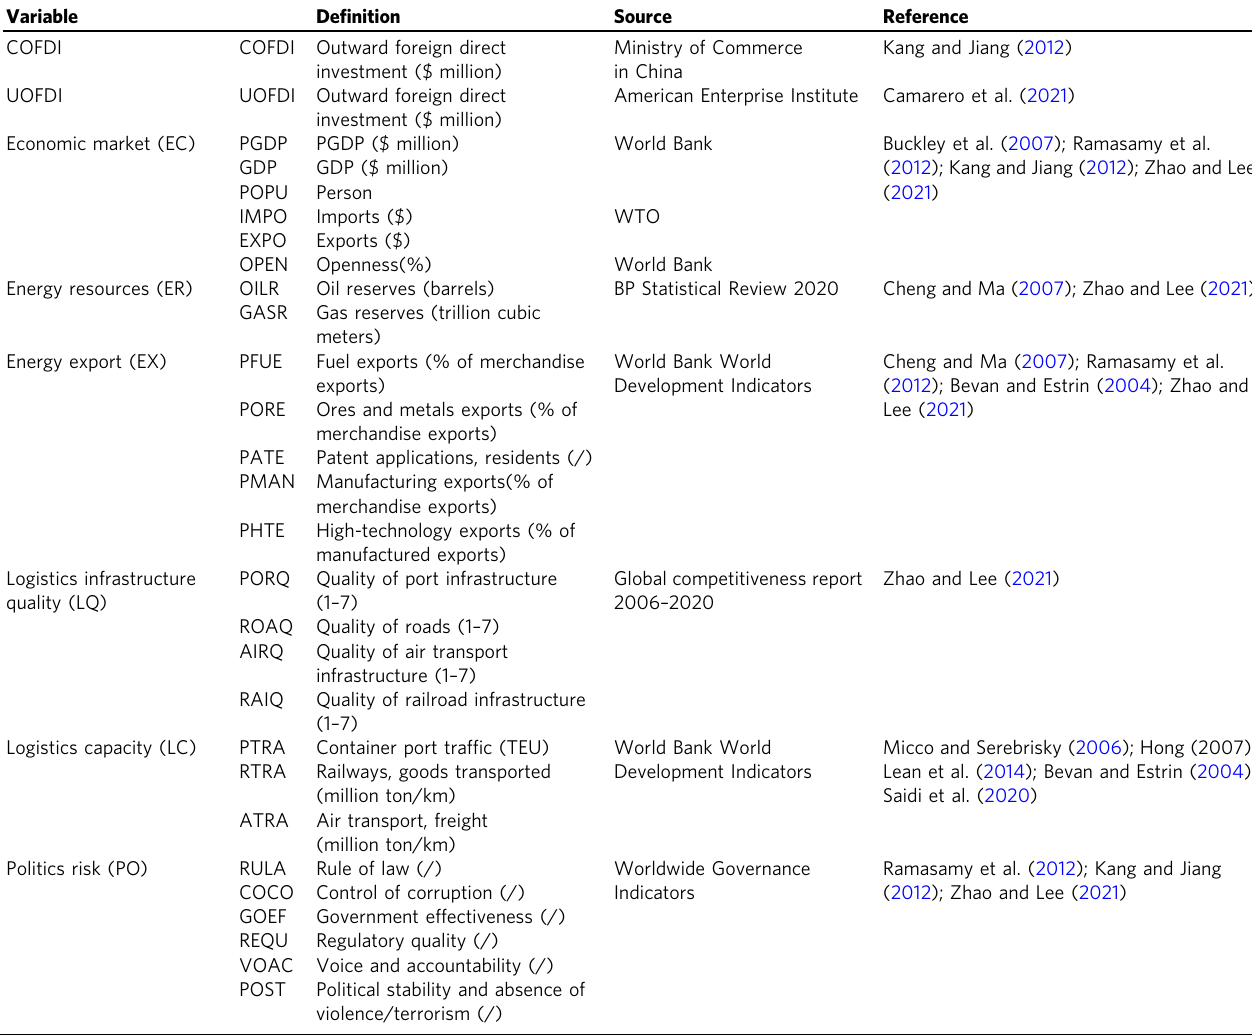
Table 1 De fi nitions and variables source.